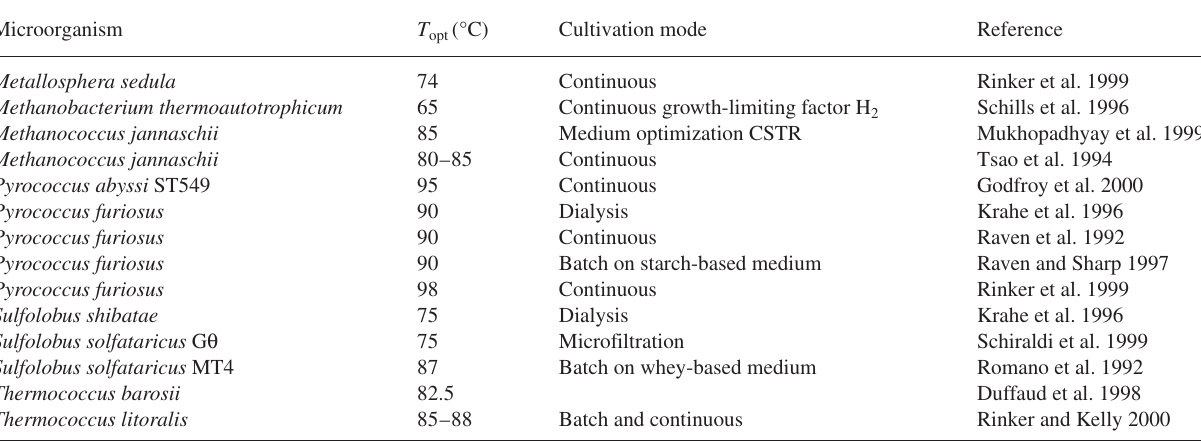
Table2. Bioreactorscalecultivationofarchaea:continuousand highcelldensityfermentation.Abbreviation: T opt = optimalgrowth temperature.